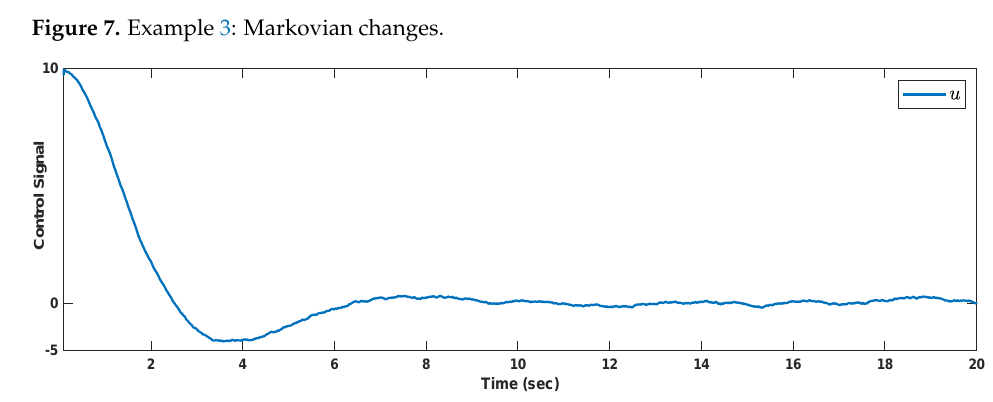
Figure 8. Example 3: Control